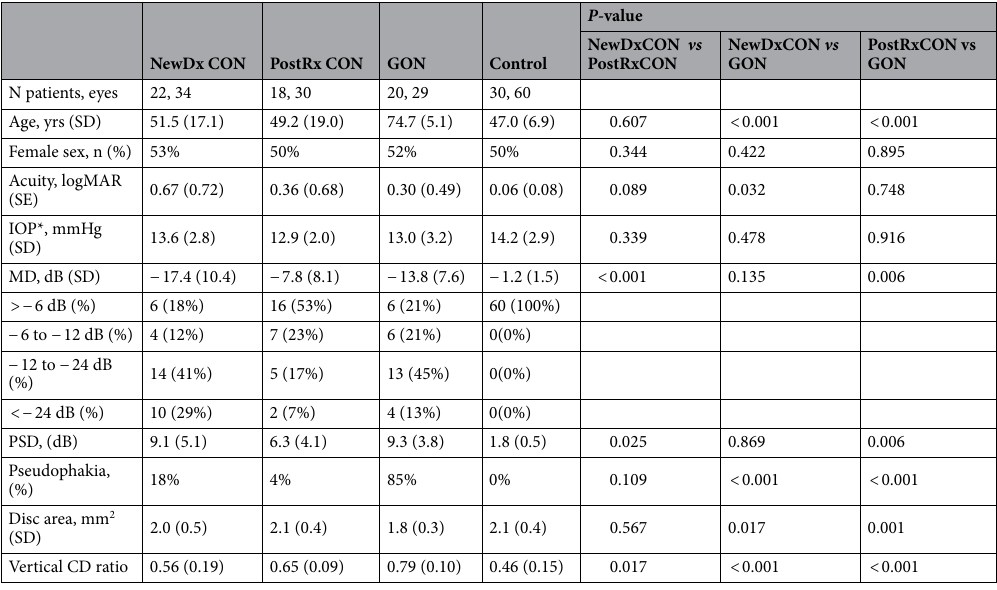
Table 1. Subject demographic and ocular characteristics, by group. NewDx CON newly diagnosed compressive optic neuropathy, PostRx CON Post-treatment compressive optic neuropathy, GON glaucomatous optic neuropathy, logMAR logarithm of the minimum angle of resolution, IOP intraocular pressure, MD mean deviation, PSD pattern standard deviation, SD standard deviation, SE standard error, CD cup to disc. p-value < 0.05 indicates statistical significance. Post-treatment CON eyes have various duration after treatment at the time of recruitment range from 2 to 72 months with mean 28.8 ± SE4.9 months, median 14 months, mode 3 months,